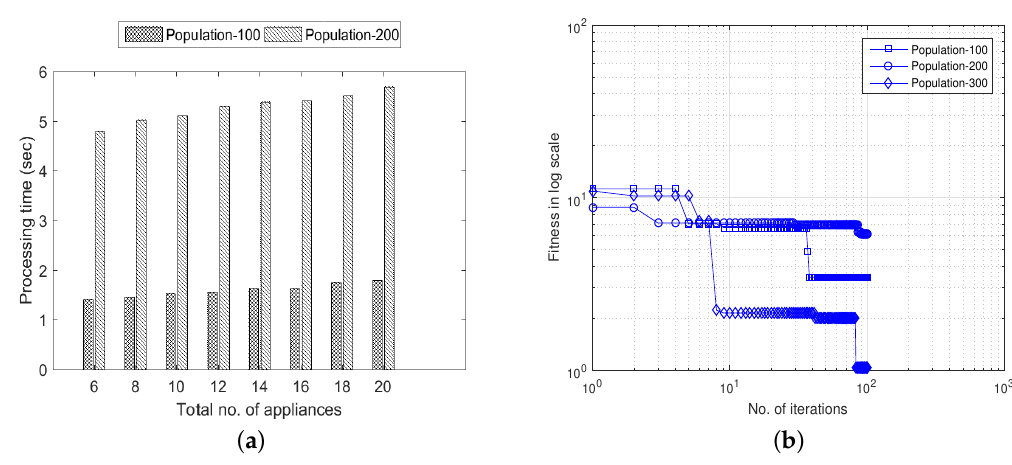
Figure 5. Comparison of processing time and fitness of GA w.r.t; (i) total no. of appliances; (ii) population size: ( a ) processing time of GA; and ( b ) fitness of GA.